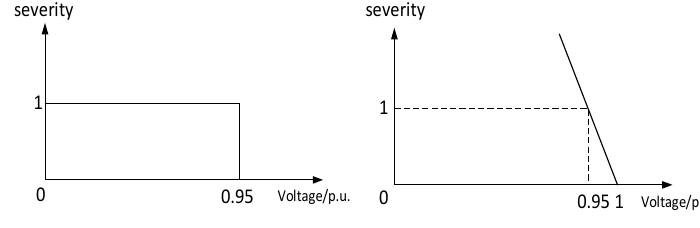
Figure 2. Low voltage severity (LVS) function.